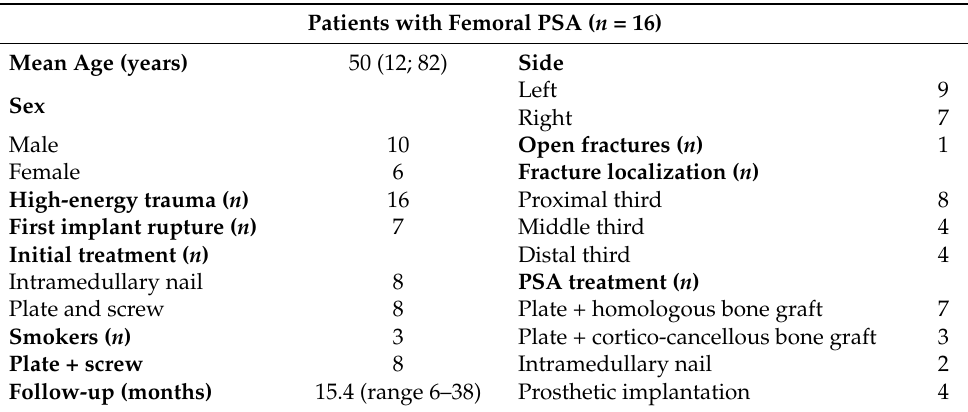
Table 1. Patient demographics and applied